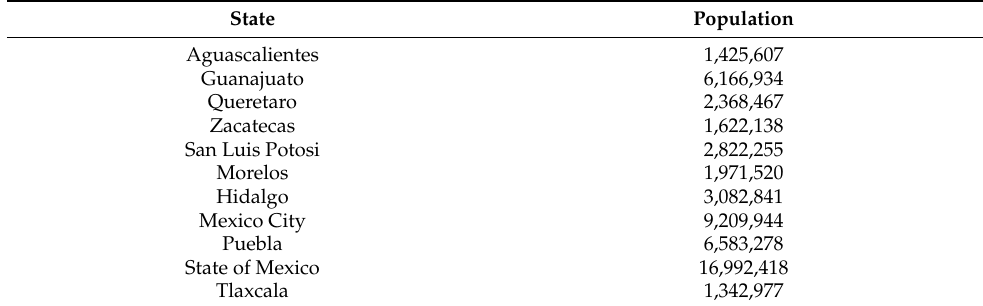
Table 3. Population in Central Mexico per state.